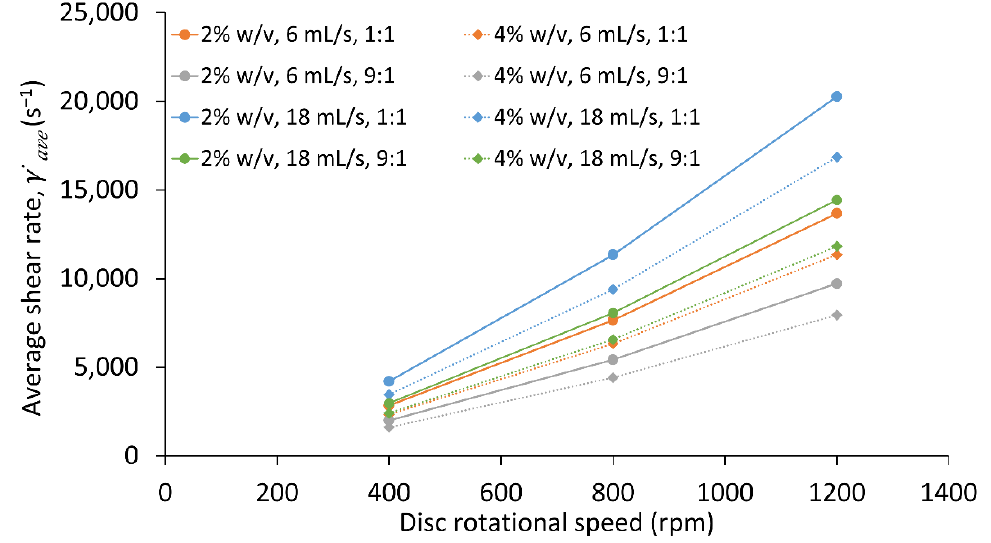
Figure 7. Average estimated viscosities of 2% w / v and 4% w / v starch solutions at varying conditions in the SDR from the power law model for starch using the expression given in Equation (1).